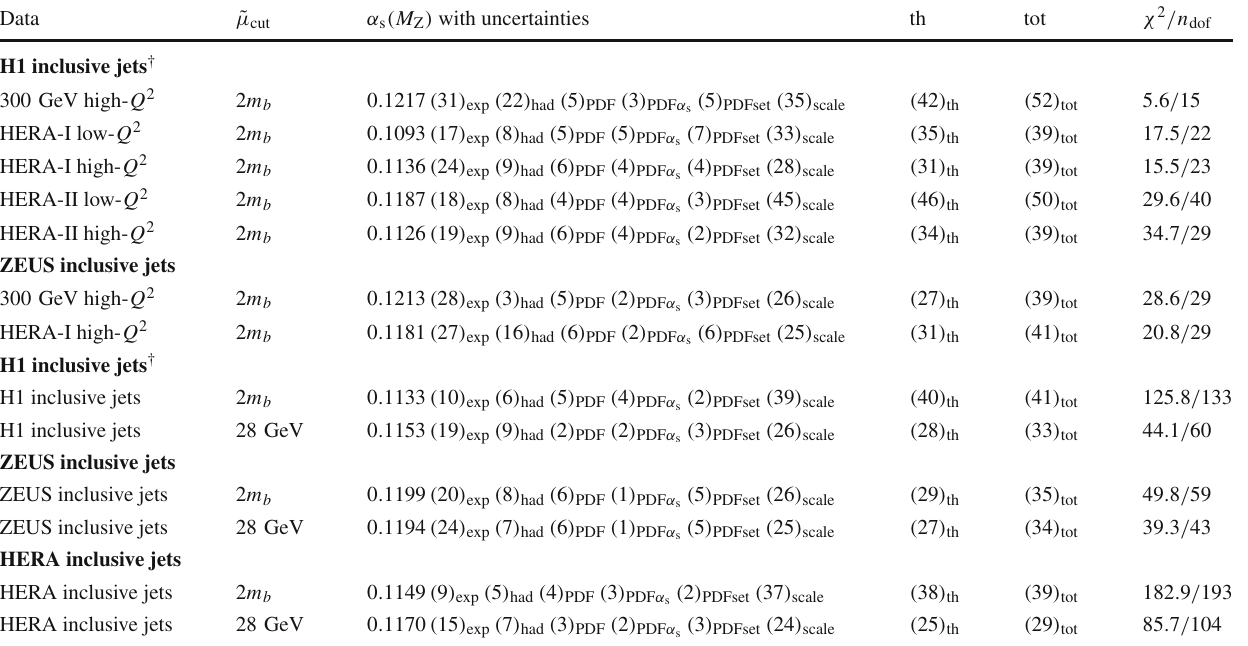
Table 1 A summary of values of α s ( M Z ) from fits to HERA inclusive jetcrosssectionmeasurementsusingNNLOpredictions.Theuncertain- ties denote the experimental (exp), hadronisation (had), PDF, PDF α s , PDFset and scale uncertainties as described in the text. The rightmost